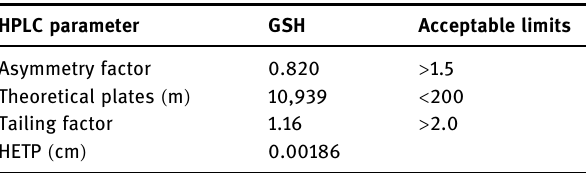
Table 6: System suitability parameters for the determination of